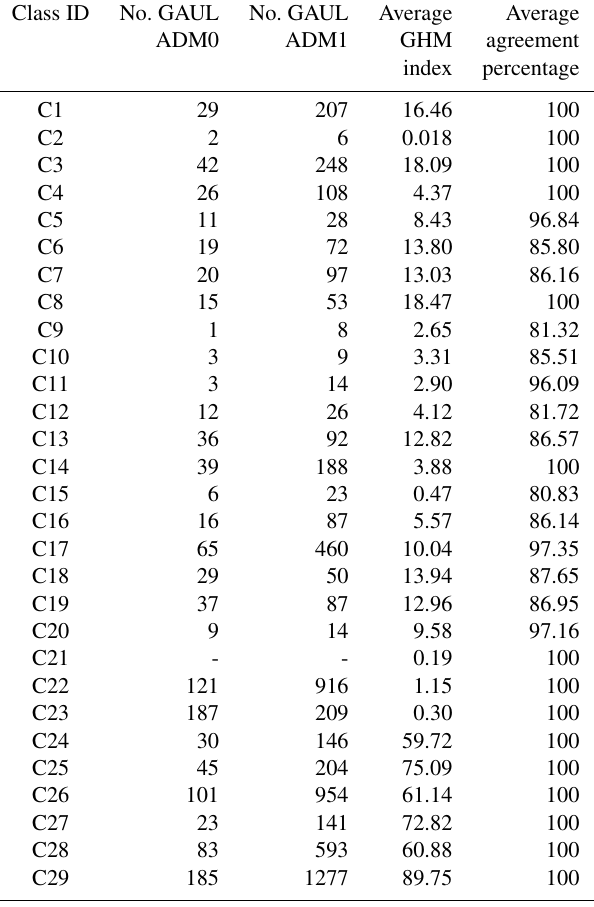
Table 9. Description of the number of Food and Agricultural Orga- nization’s Global Administrative Unit Layers 2015 (GAUL) parti- tions ADM0 and ADM1, the average GHM index, and the average agreement percentage for the imbalanced version of the data. The number of ADM0 and ADM1 partitions for the class “marine water bodies” (C21) is not provided because the GAUL partitions do not cover the seas and